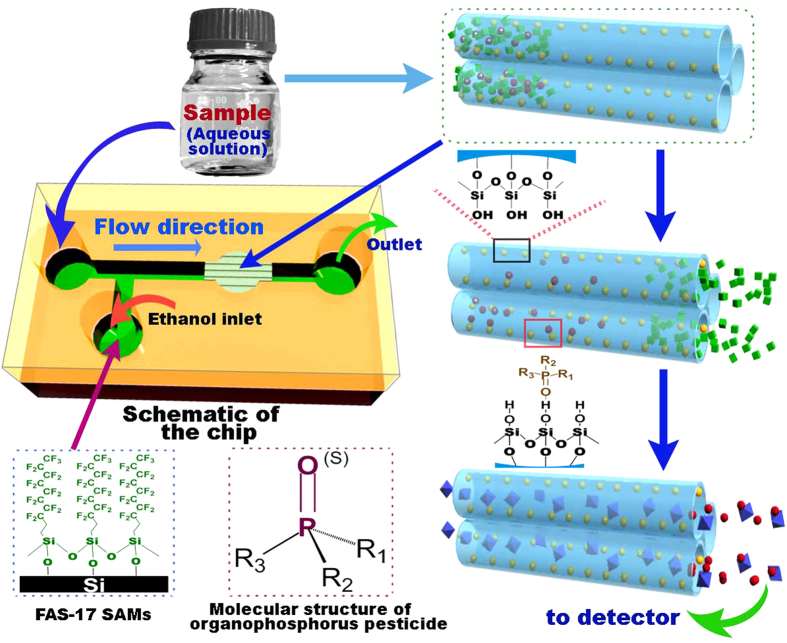
Schematic procedure for pre-extracting/enriching trace OP pesticide from aqueous solution to a water-miscible organic solvent.The photograph of the glass bottle was taken by P.C.X.